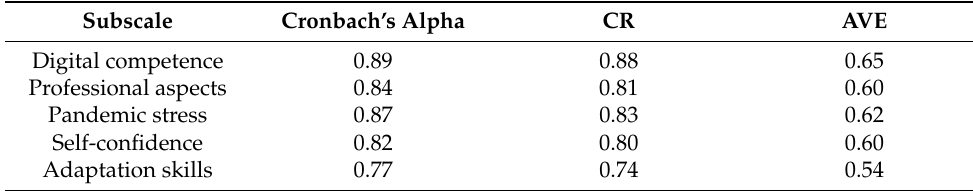
Table 4. Cronbach’s alphas, CR and AVE of the